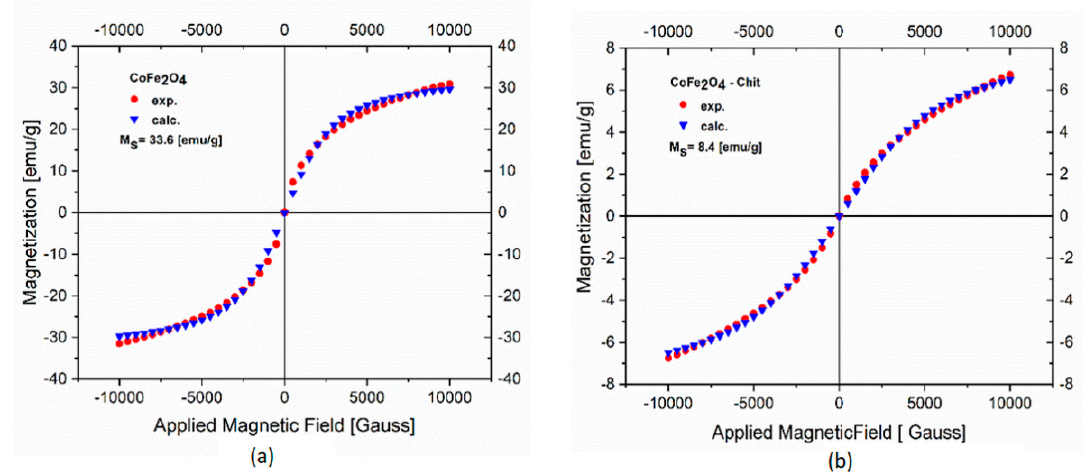
Figure 8. Magnetic hysteresis curves of CoFe 2 O 4 ( a ) and CoFe 2 O 4 − Chit ( b ) at room